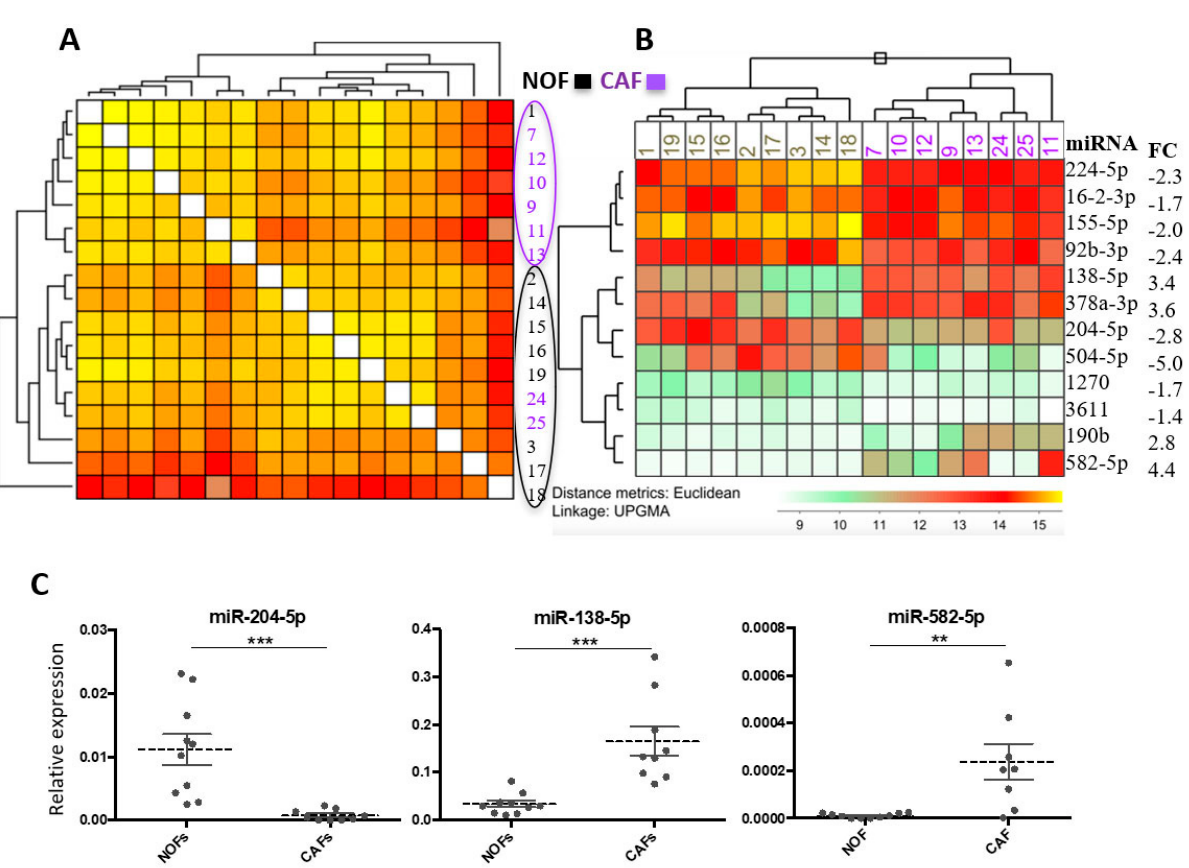
Figure 1. ( A ) Unsupervised hierarchical sample clustering of CAFs and NOFs for miR expression. ( B ) Clustering analysis by fibroblast type for 12 significantly differentially regulated miRs (SAM analysis). Significantly altered miRs (FDR = 0) and corresponding fold changes (FCs) on the right. ( C ) miR validation of microarray results by qRT-PCR (** p < 0.005, *** p <